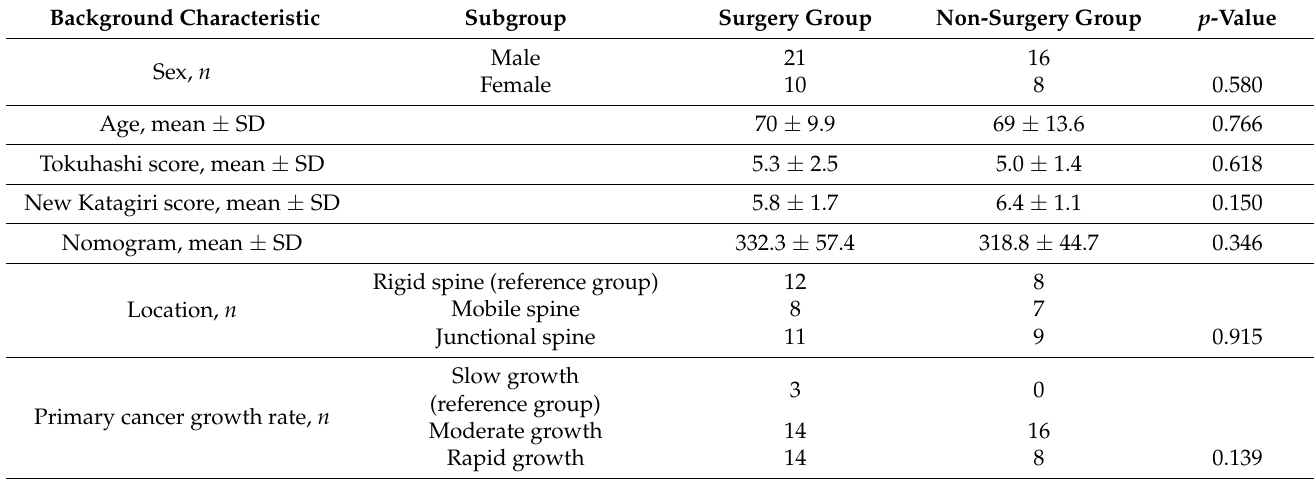
Table 1. Baseline demographics and clinical characteristics of patients who underwent surgery and of those who did